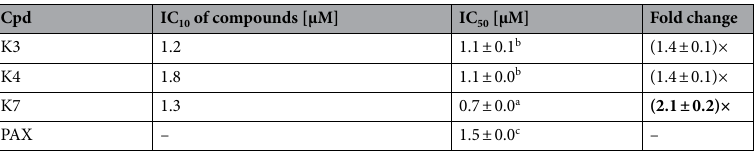
Table 4. The sensitization potential of selenoesters against paclitaxel-resistant human breast carcinoma cell line MCF- 7/PAX. Tested compounds were applied in single dose (IC 10 ) and paclitaxel in concentration range in order to determine its concentration halving the viability (IC 50 ). Fold change was calculated as the ratio of IC 50 of paclitaxel and IC 50 of paclitaxel in the presence of IC 10 dose of compound. Data are expressed as the average inhibitory concentration (IC 50 ) or fold change of three repetitions with standard error of the mean (SEM). Fold change higher than 1 indicated the synergistic effect of paclitaxel and selenoesters. The statistical differences between compounds were calculated by one-way analysis of variance (ANOVA) and Duncan’s post hoc test (p ˂ 0.05), where significances were denoted by different letters (a–c). Significant values are in [bold].